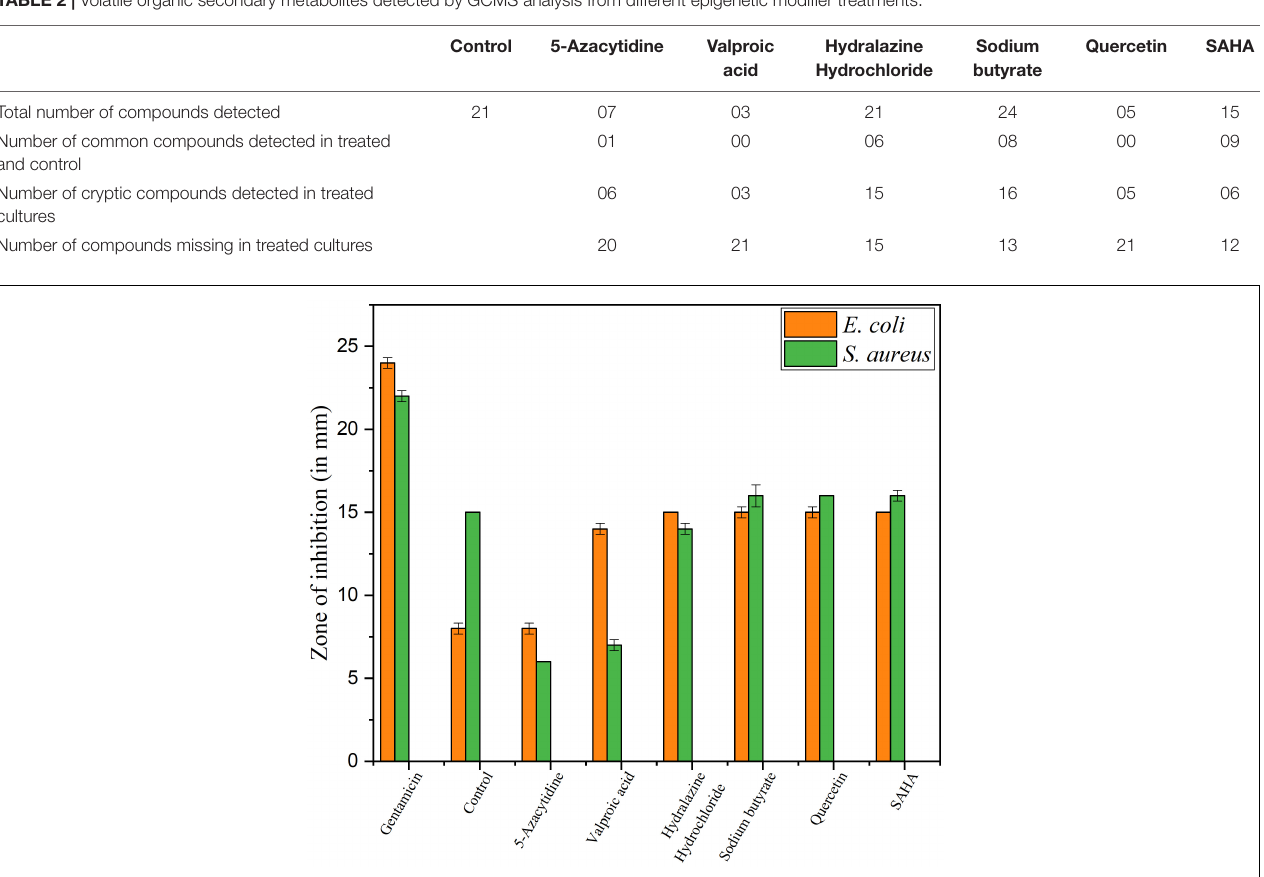
FIGURE 3 | Antibacterial activity values of Disc diffusion assay for epigenetic treated crude